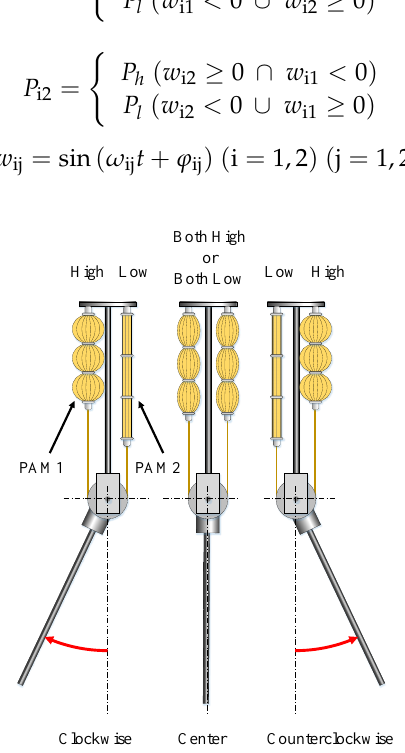
Figure 6. Relationship between PAM pressure and joint motion.